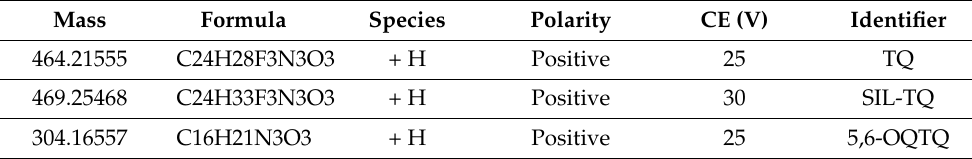
Table 7. QExactive Plus Inclusion List for Parallel Reaction Monitoring